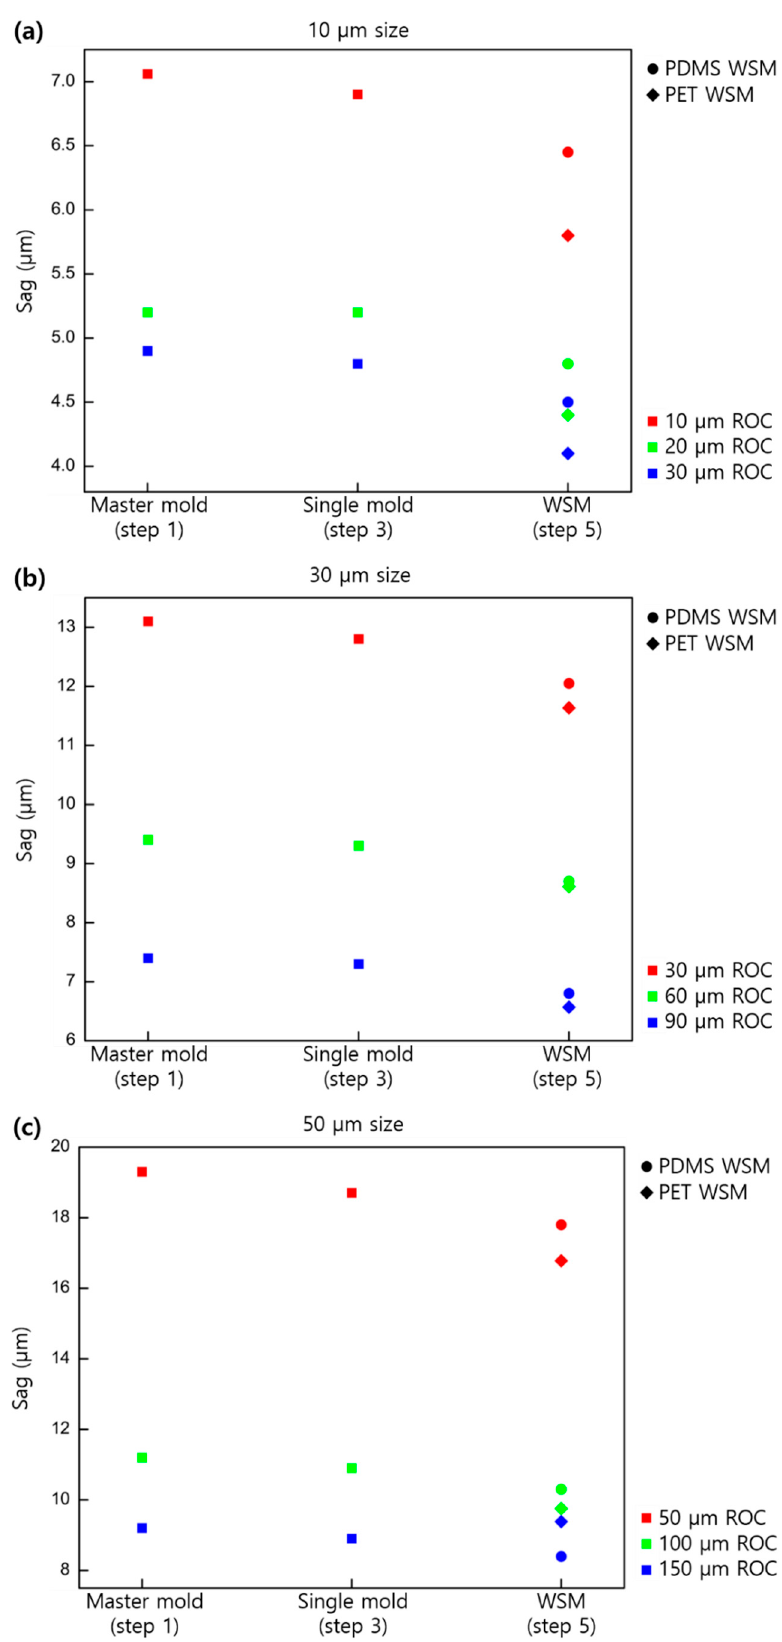
Figure 3. Sag profiles based on the lens size and shapes of the convex replicated samples: ( a ) 10, ( b ) 30, and ( c ) 50 µm in pitch.